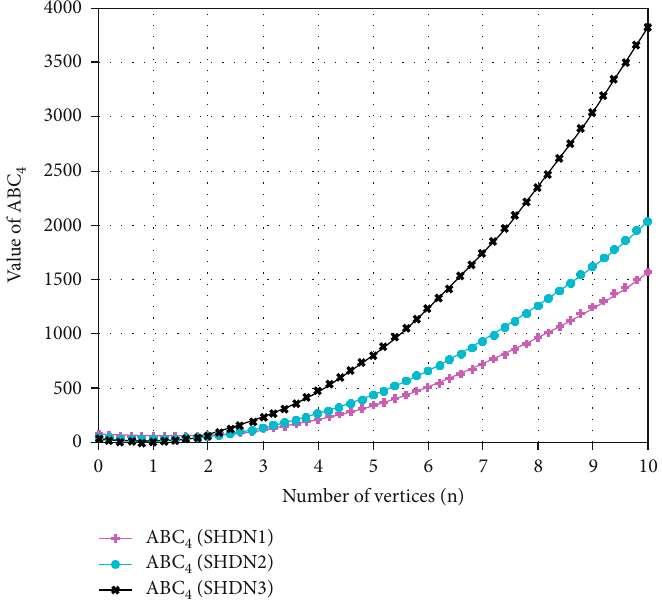
n Þ , Γ n Þ , and Γ n Þ using 2D graphs of GA 1 ð 2 ð 3 ð